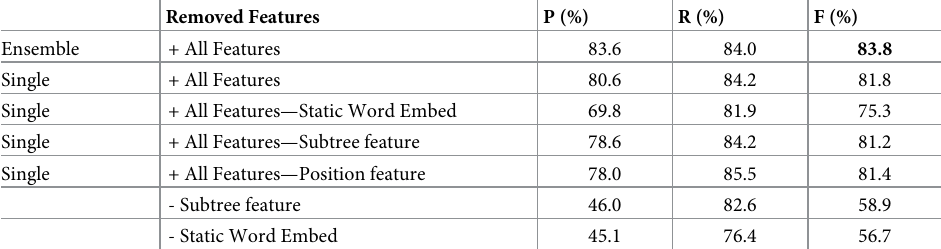
Table 6. Changes in our model’s performance in DDI detection by removing several features of our